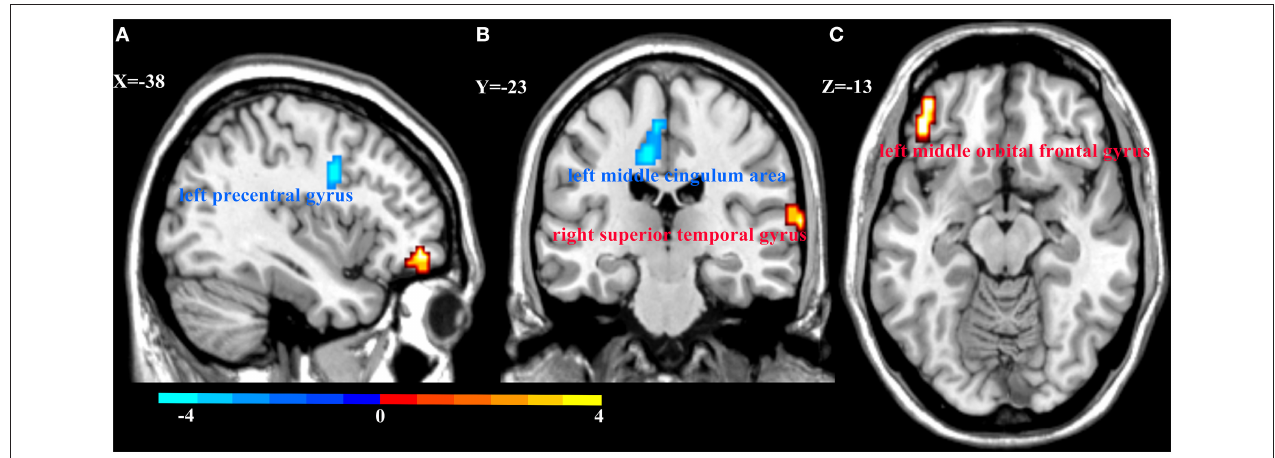
FIGURE 3 | Regional homogeneity (ReHo) alterations in MDD patients and HCs. Compared with HCs, patients with MDD showed decreased ReHo in the left precentral gyrus (A) and left middle cingulum area (B) , and increased ReHo in the right superior temporal gyrus (B) and left middle orbital frontal gyrus (C) . Color bar represent the t -value.